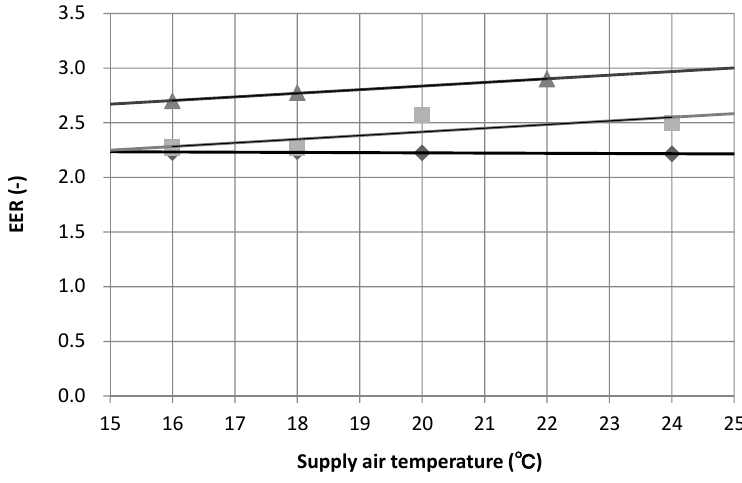
Figure 4. Changes in the system EER according to supply air temperature.